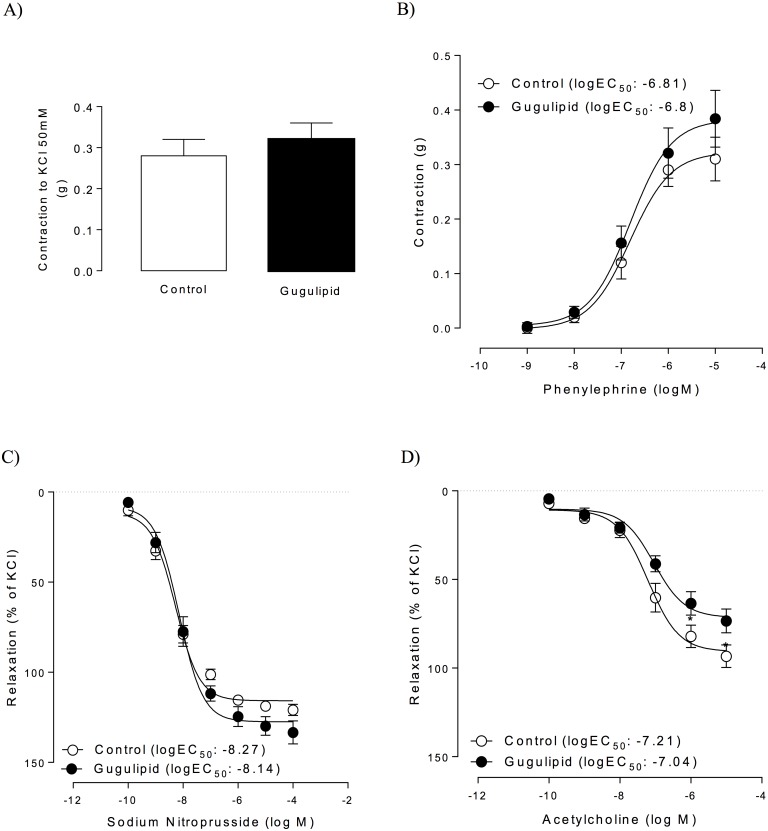
Effect of gugulipid on aortic vascular reactivity in male C57BL/6 mice.(A) Overall aortic contraction induced by KCl, (B) phenylephrine-induced vascular contraction, (C) sodium nitroprusside-induced relaxation, and (D) acetylcholine-induced relaxation in control and gugulipid-treated mice. In parenthesis is half-maximal effective dose (EC50) for each condition. Six independent experimental sets were used. In each experiment, vascular reactivity was assayed in parallel in one control and one gugulipid-treated mouse; n = 6 in each set. Values represent mean ± SD. *P<0.05.